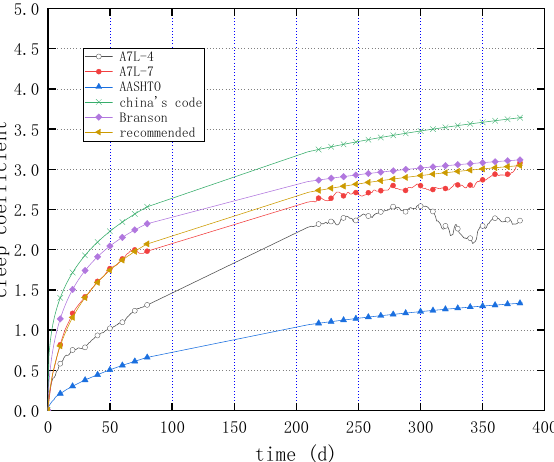
Figure 19. Evolution of creep coefficients of specimens via various approaches (loading age of 3 days).